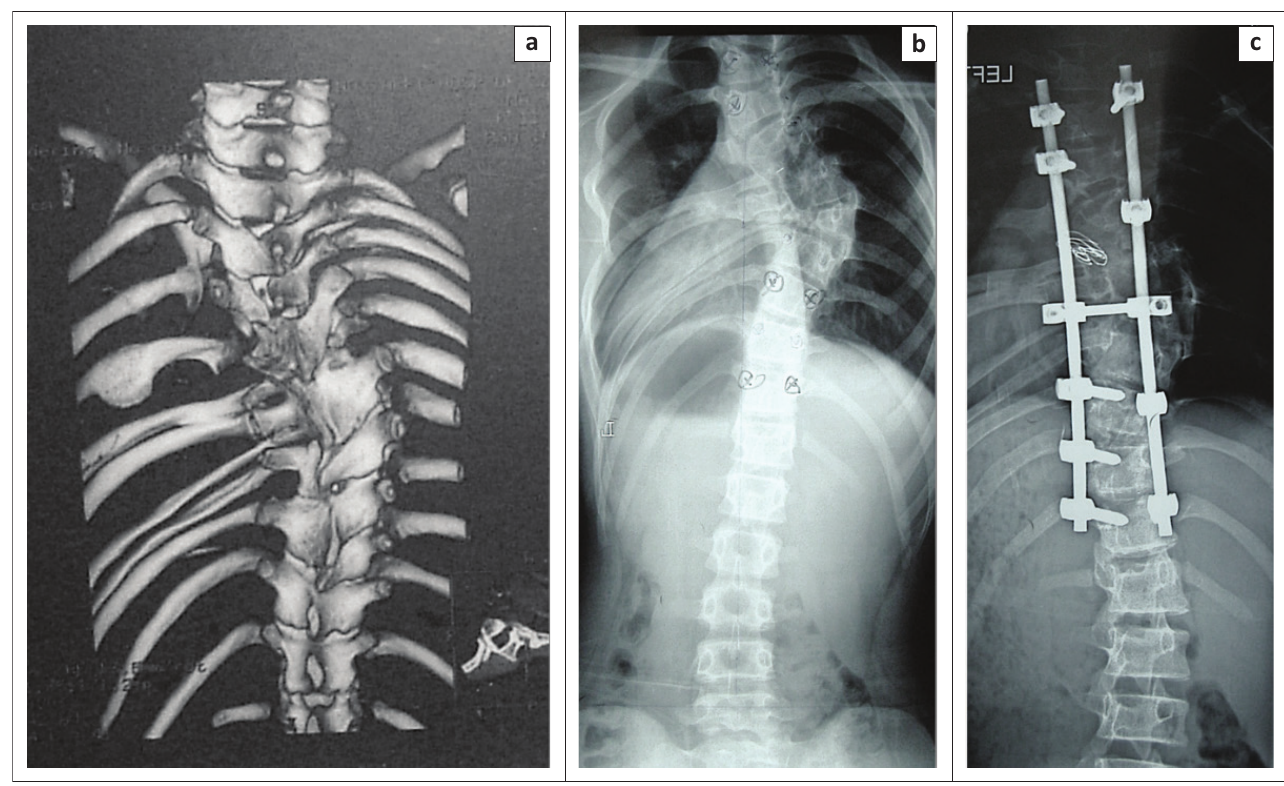
FIGURE 2: (a) CT reconstruction of the spine and ribs in a patient with congenital scoliosis including vertebral malformations and a segmentation disorder (rib synostosis). (b) Native x-ray, and (c) Spine after dorsal double rod instrumentation with pedicle screw